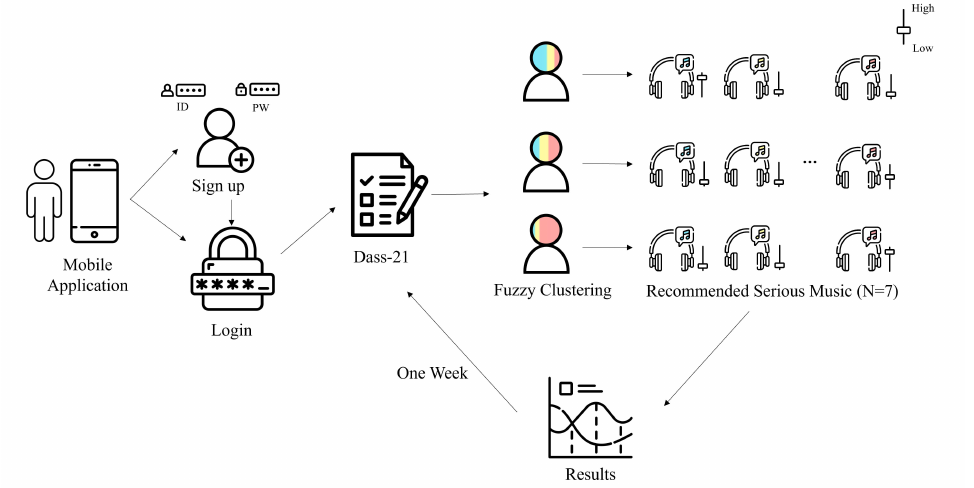
Figure 2. The music recommendation service process in mobile